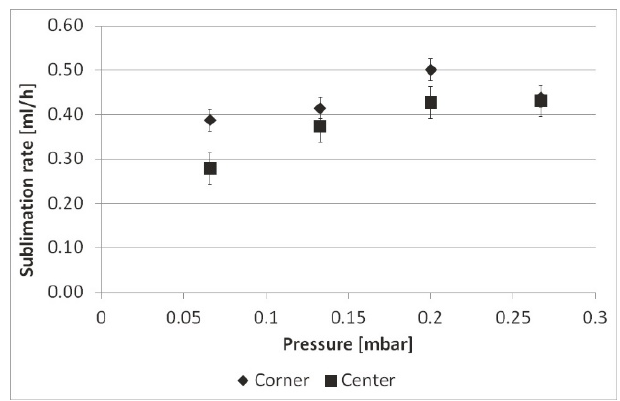
Figure 7. Mean sublimation rates in the rack at 0.066 mbar, 0.133 mbar, 0.200 mbar and, 0.267 mbar.